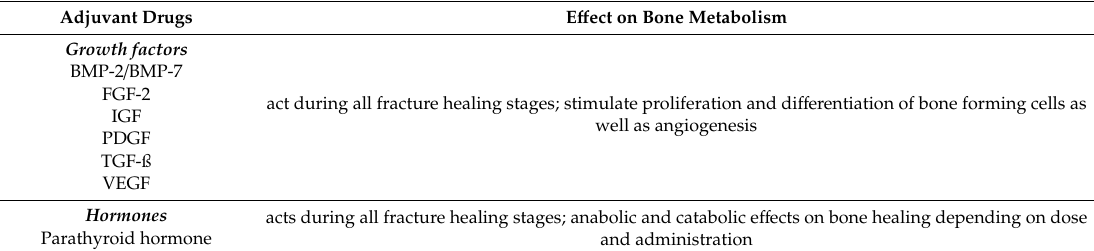
Table 1. Summary of selected adjuvant drugs for local drug delivery approaches being discussed in this work and their e ff ects on bone fracture healing. Their molecular targets, mechanisms of action, direct e ff ects on bone metabolism and side e ff ects have been described in detail elsewhere